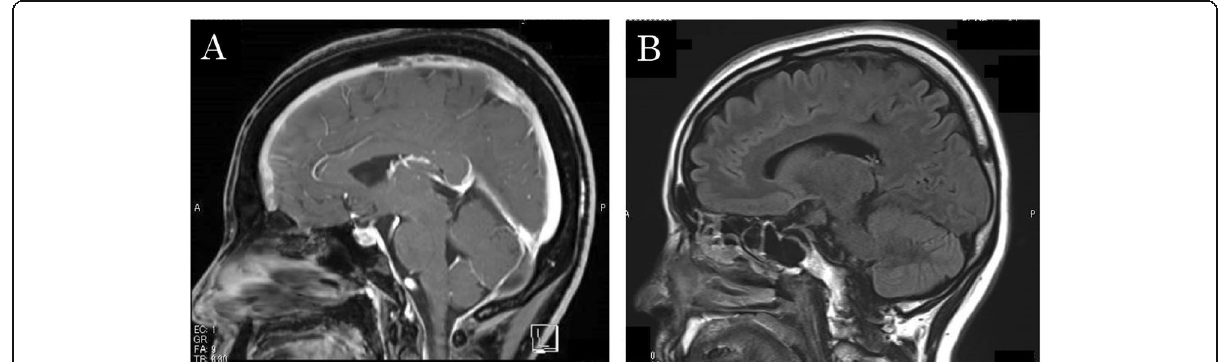
Fig. 4 a Sagittal T1-weighted gadolinium-enhanced MRI. Baseline imaging shows diffuse pachymeningeal enhancement, sagging of the brain, enlargement of the pituitary gland, and coarctation of the lateral ventricles. b Imaging after EBP placement shows resolution of brain sagging, smaller pituitary gland, resolution of pachymeningeal enhancement, and resolution of lateral ventricle narrowing. EBP, epidural blood patch; MRI, magnetic resonance